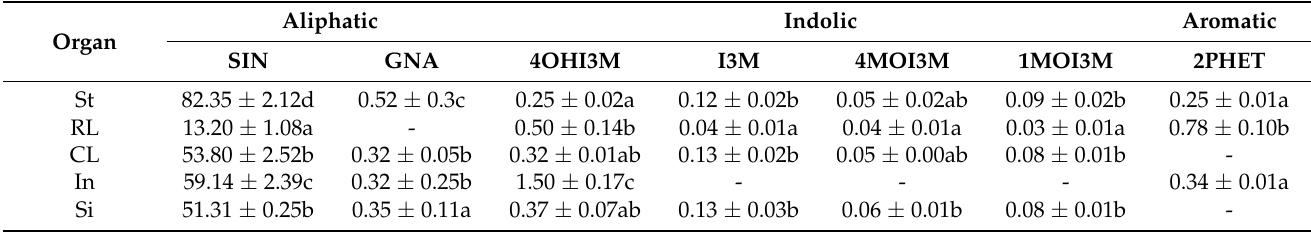
Table 1. Glucosinolate content ( µ mol · g − 1 DW) in different organs of Brassica nigra .